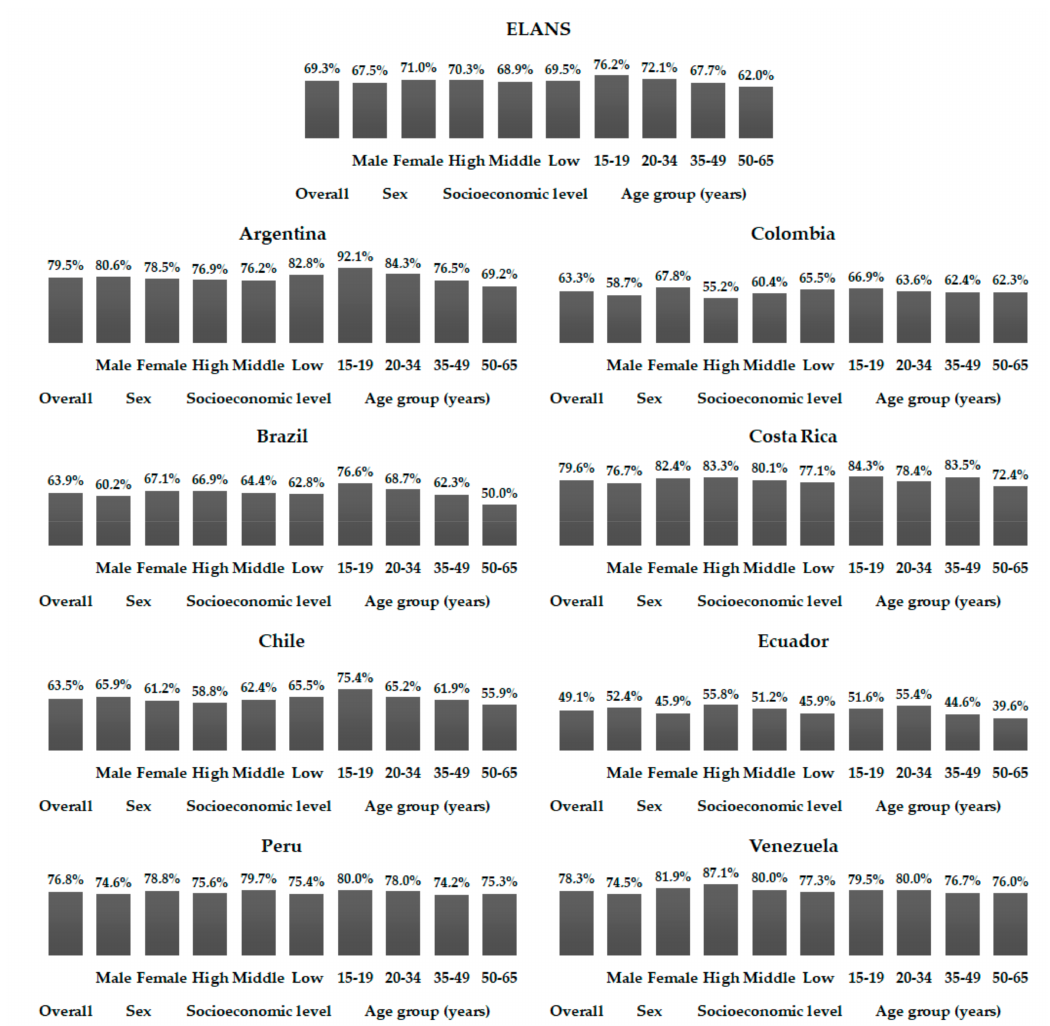
Figure 1. Percentages of individuals with added sugar intake up to 10% of the total energy intake among Latin American countries, according to gender, socioeconomic level, and age ranges; Latin American Health and Nutrition Study (ELANS), 2015.